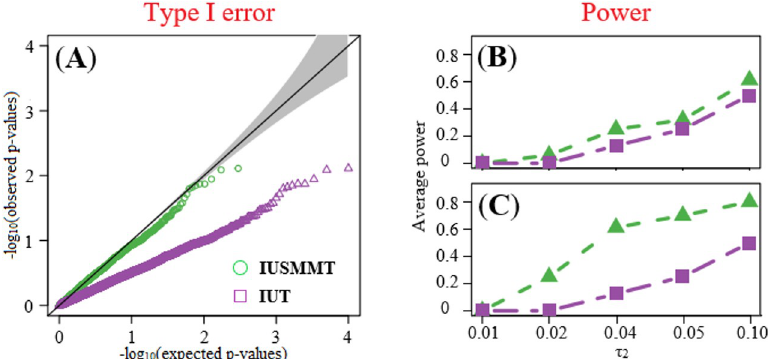
Fig 3. The QQ plot ( A ) and the average power curve ( B - C )for IUSMMT and IUT. The QQ plot (A) is under the scenario of sparse nulls. The average power curve is calculated when the mediation strength parameter τ 2 increases under the sparse alternative (B) and the dense alternative (C). Here, n = 400, β = 0.3, and τ 2 = 0.01, 0.02, 0.04, 0.05 or 0.10 at the x-axis. The magnitude of τ 2 quantifies the strength of association between DNA methylation CpG sites and gene expression. In B and C, the number of genes (i.e., mediators) was set to 10 4